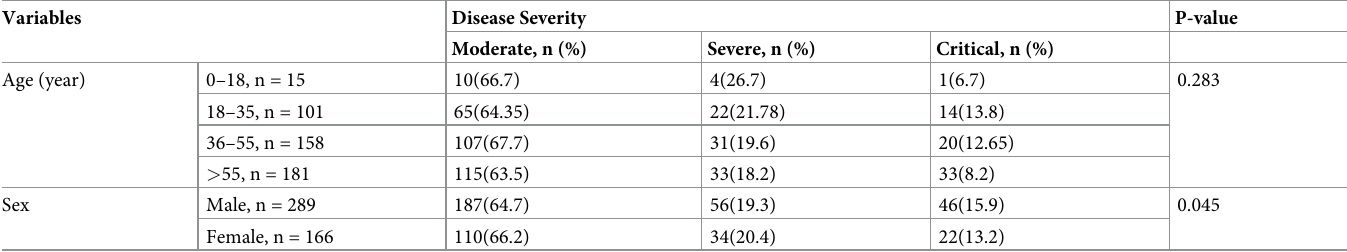
Table 2. Socio-demographic characteristics and disease severity of COVID-19 patients. Variables